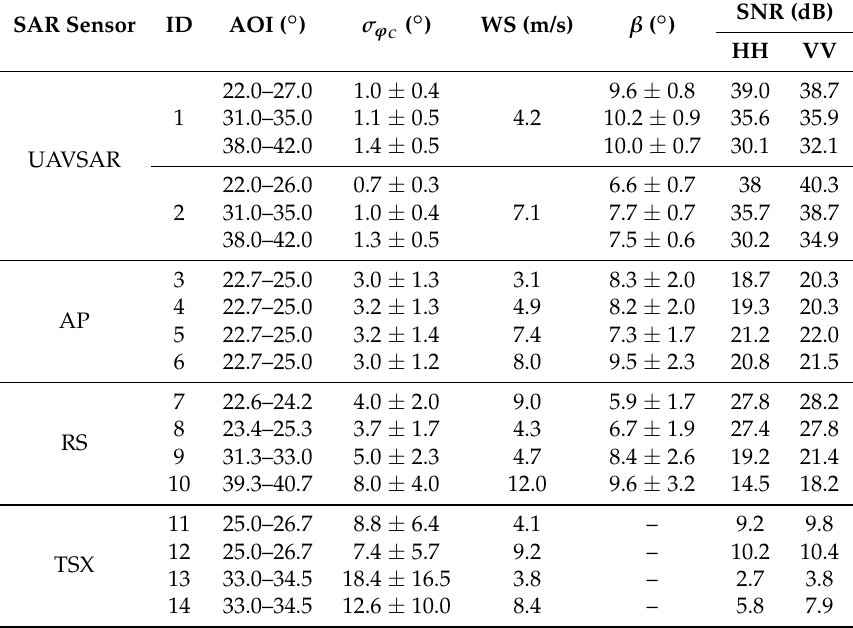
Table 3. Values of σ ϕ , β and HH and VV SNR evaluated within ROIs selected over a homogeneous C sea surface area. σ ϕ and β are presented as mean ± standard deviation C